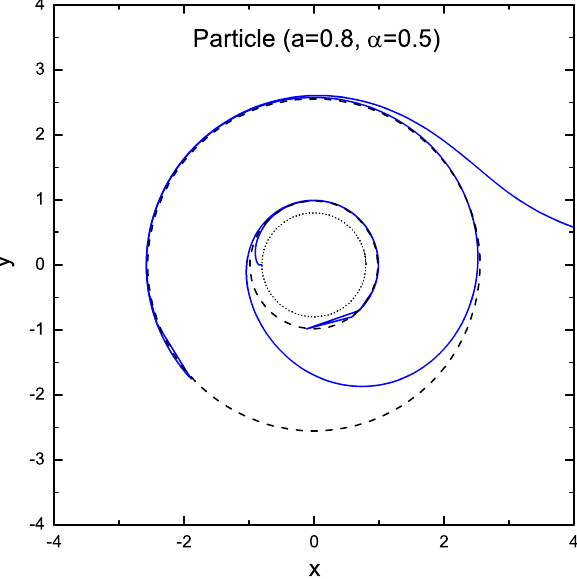
Fig. 6 ThetrajectoryofatestparticleoftheKerr-MOGblackholewith a = 0 . 8 and α = 0 . 5. As a test particle approaches the two horizons, it is bending rapidly to the ring singularity comparing with Kerr black